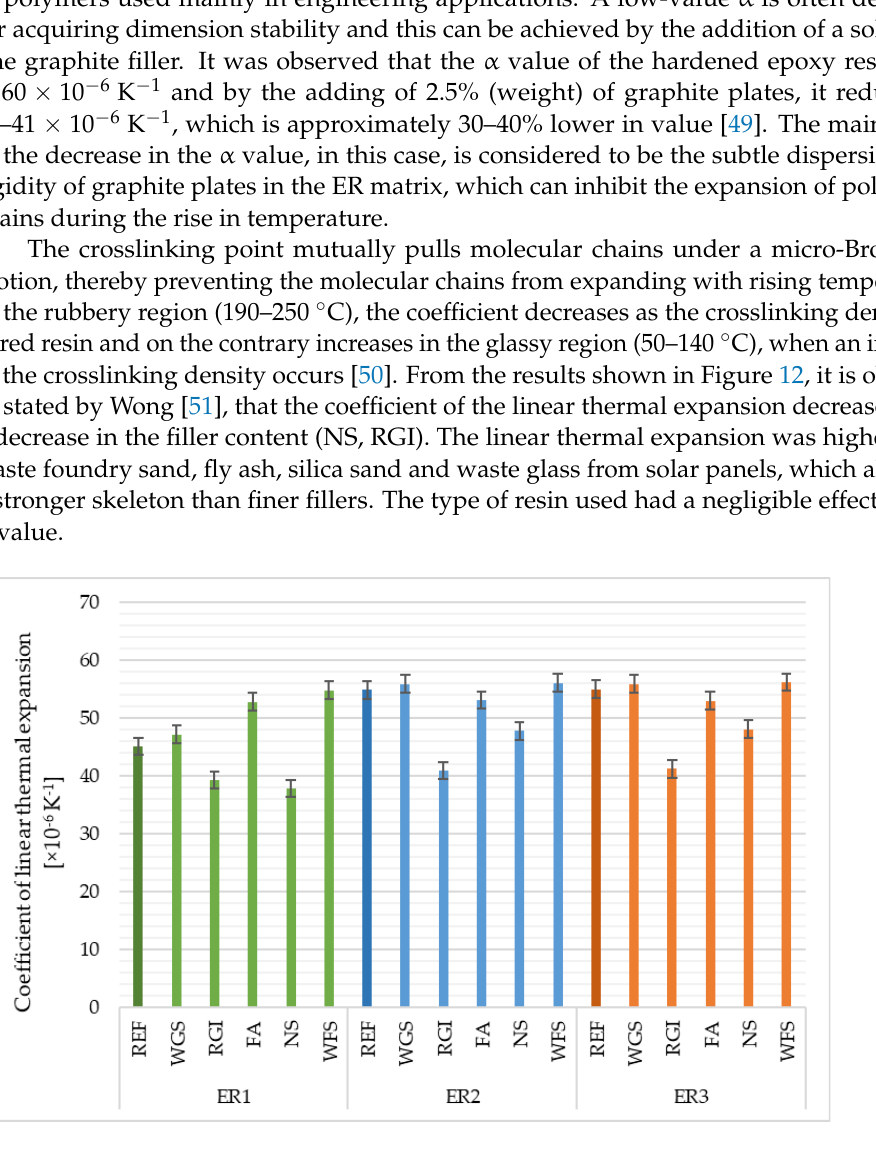
Figure 12. Coefficient of linear thermal expansion of epoxy composites depending on the type of filler and epoxy binder used.